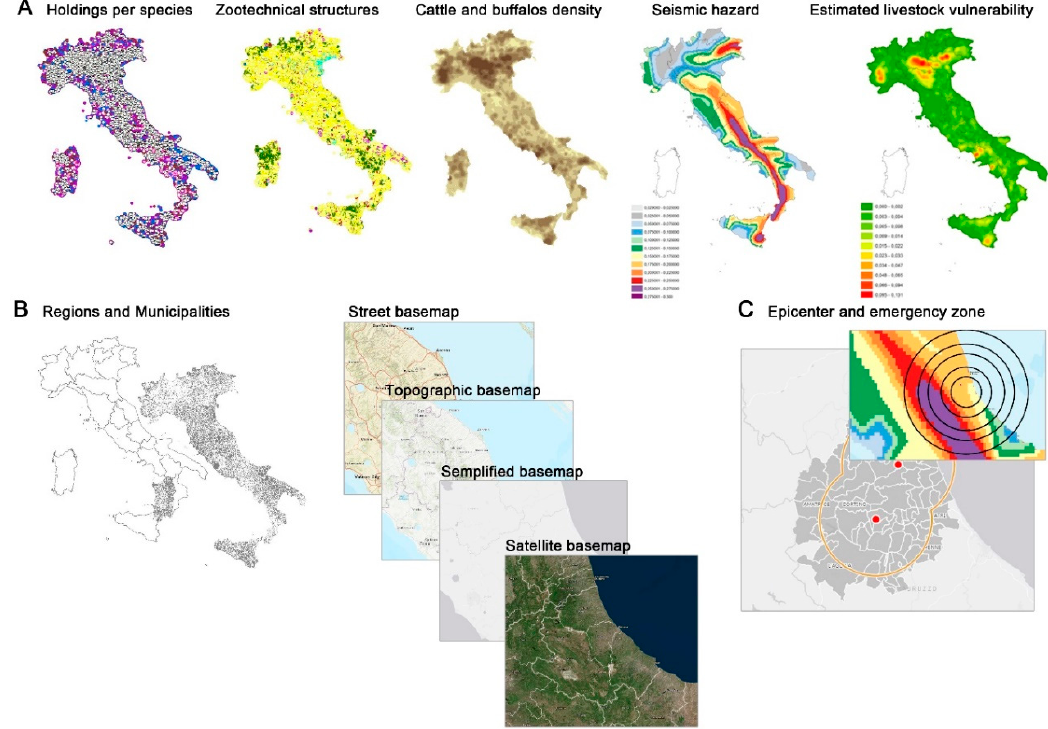
Figure 5. ( A ) Geodatabase datasets: holdings per species, livestock farms, animal density per species, the seismic hazard, and the estimated seismic livestock vulnerability. ( B ) Additional layers displayed in the web GIS: administrative boundaries (regions and municipalities) and base maps, including street, topographic, simplified, and satellite. ( C ) The simulated seismic zone.